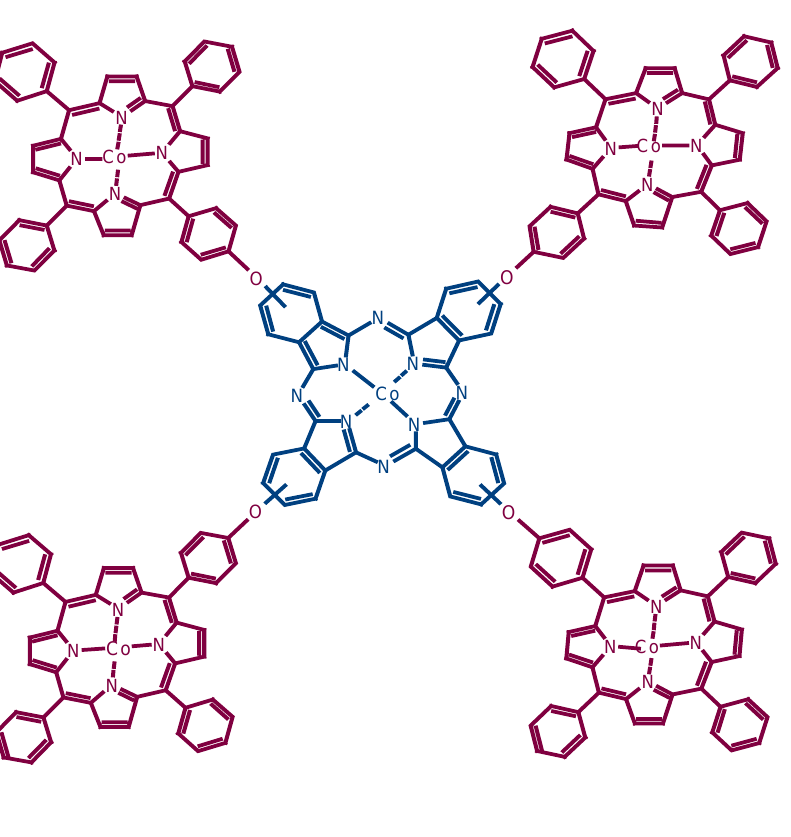
Figure 1: The molecular structure of a cobalt phthalocyanine-cobalt porphyrin (CoPc-(CoTPP)